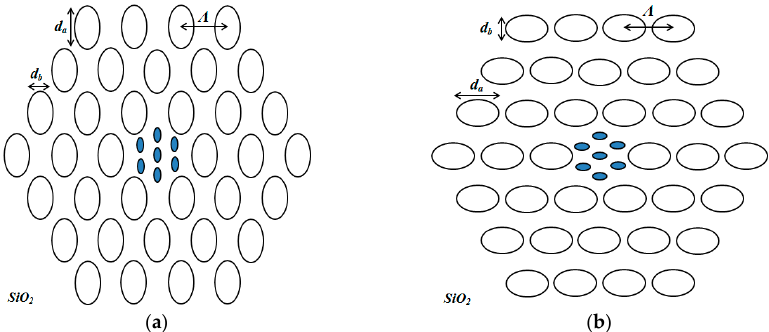
Figure 1. ( a ) Schematic depiction of the Vertical air holed PCF (V-PCF) and ( b ) Horizontal air holed PCF (H-PCF). PCF